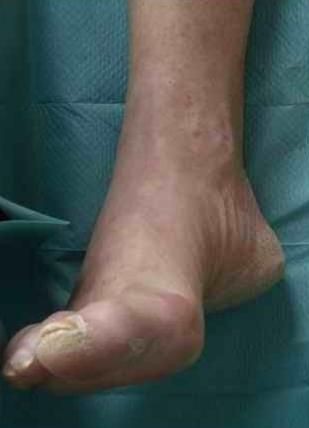
Same foot as in Figure 5, after 3 months of offloading and immobilisation (healed Charcot foot stage 0, restitution ad integrum).